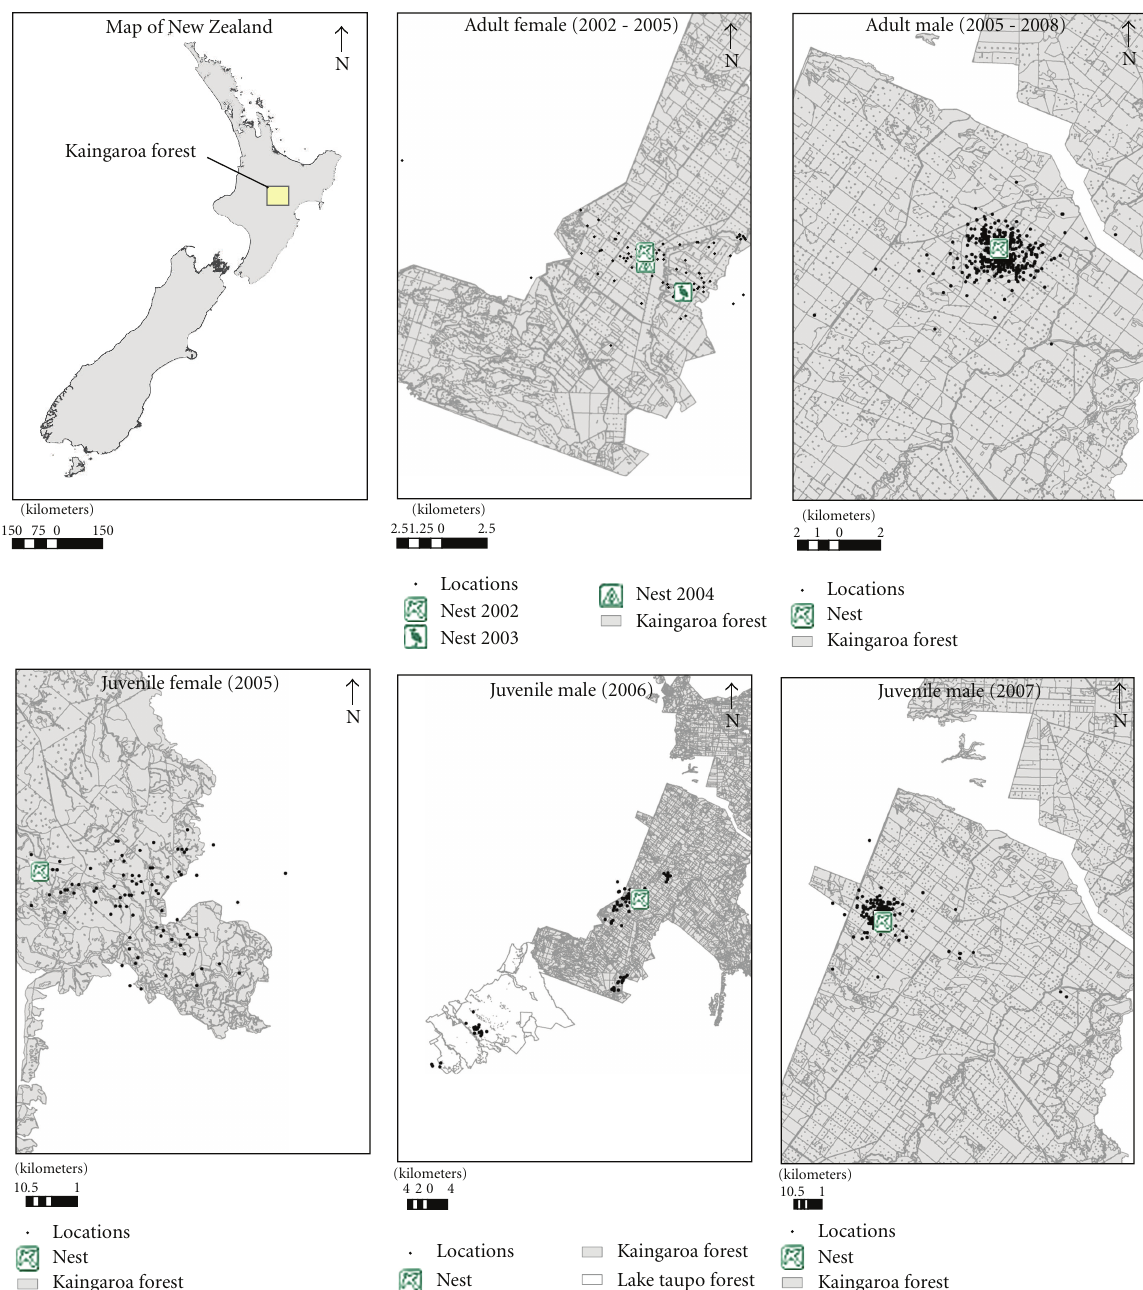
Figure 1: Locations and nest sites of two adult and three juvenile New Zealand falcons in Kaingaroa Forest, New Zealand.